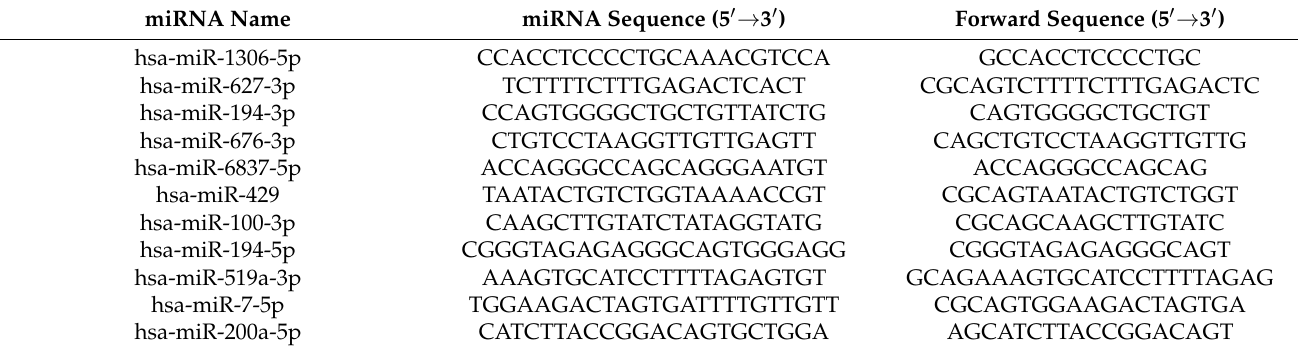
Table 4. List of 11 miRNA primers for real-time